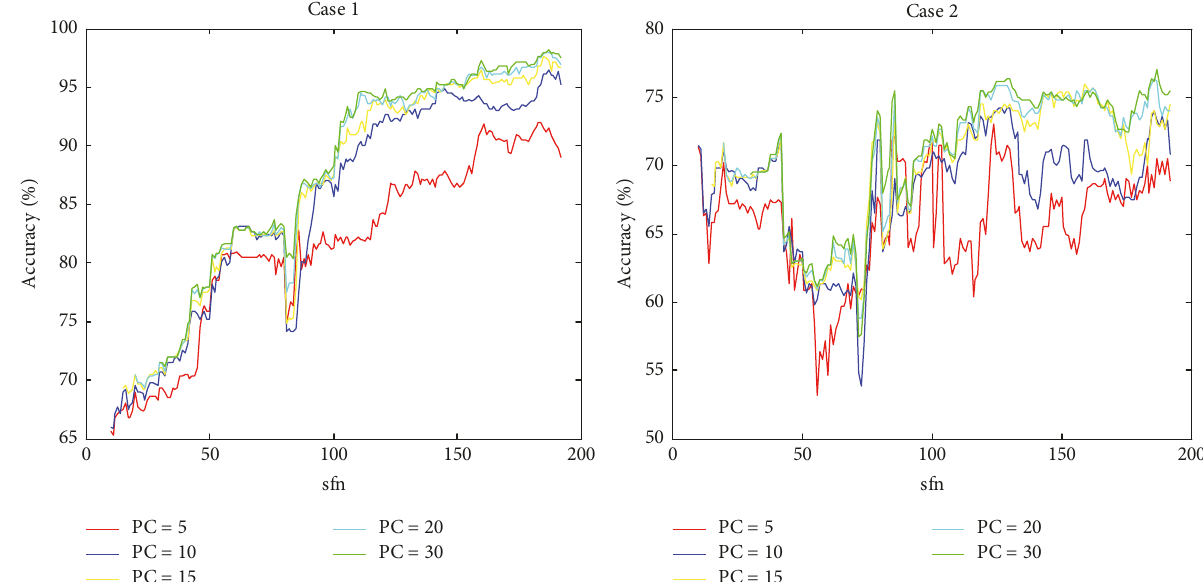
Figure 30: The diagnosis results obtained by OFS-FSASD-PCA-SVM with different number of dimension sizes for PCA. The PC represents the number of dimension sizes.